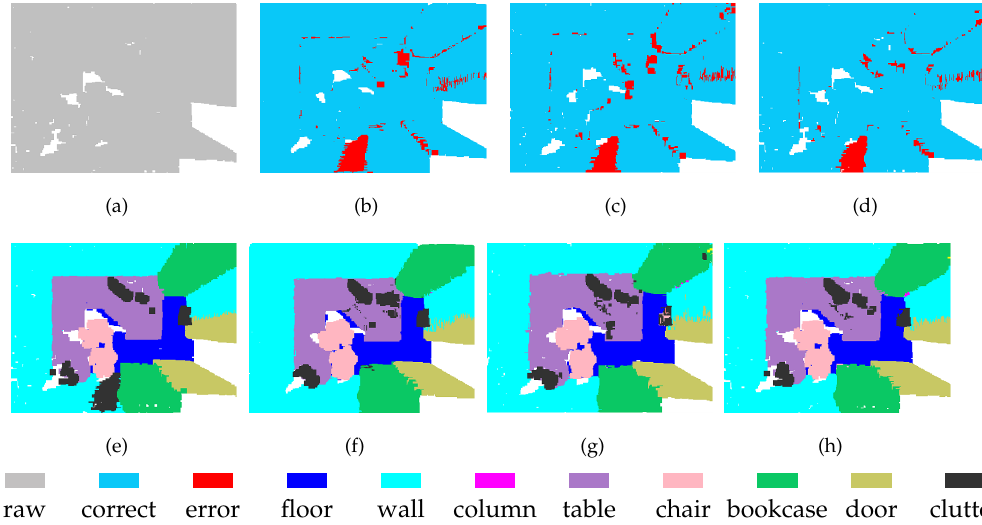
Figure 9. Segmentation results on S3DIS-6 dataset: ( a ) input, ( e ) ground truth, ( b , f ) Level-1, ( c , g ) Level-2, and ( d , h )